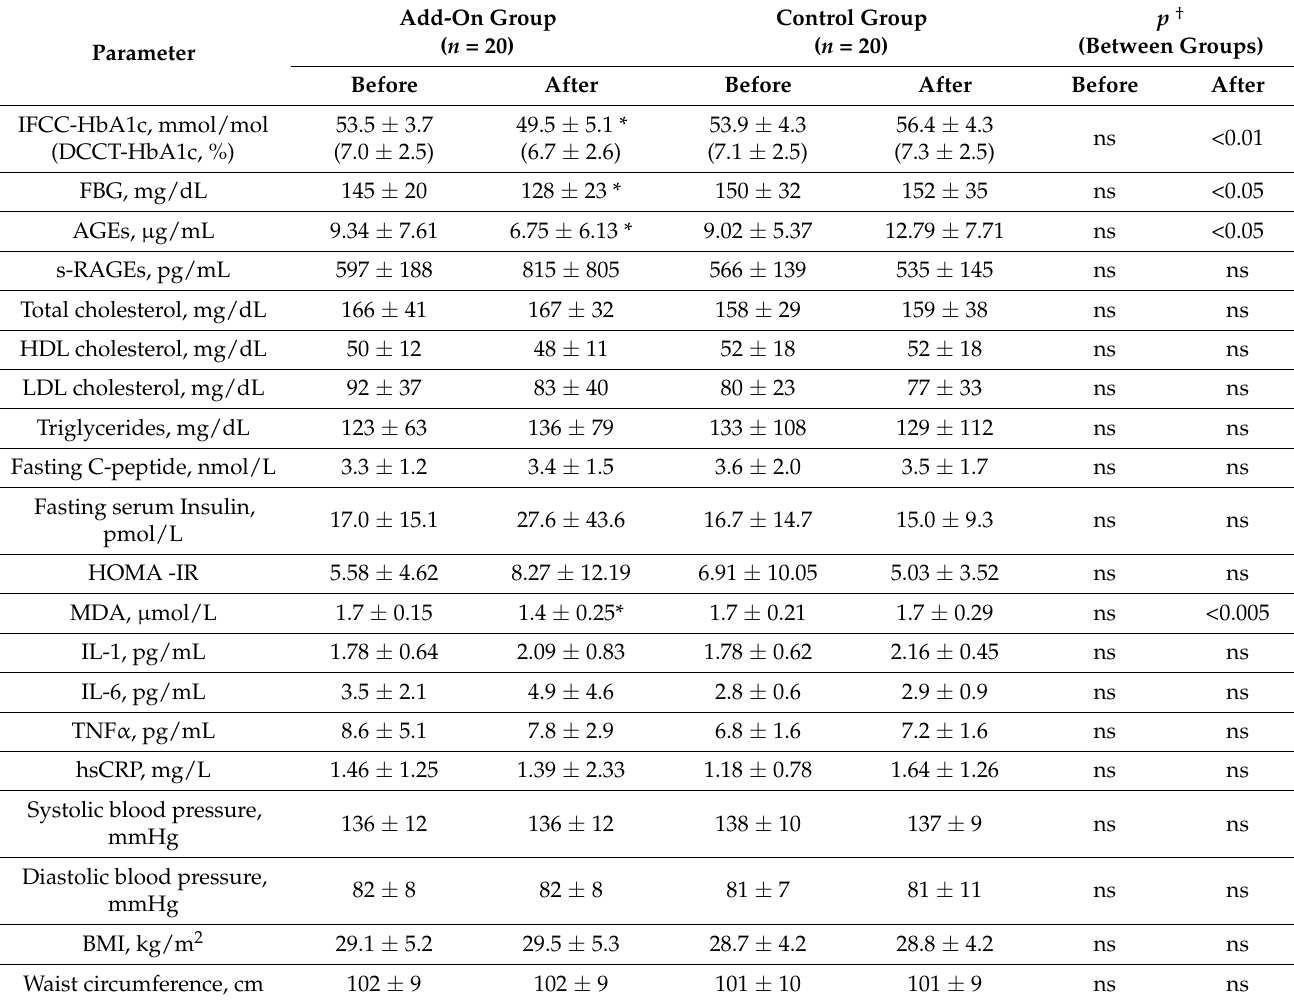
Table 2. Hematochemical parameters of patients at the baseline and after 12 weeks of treatment. For continuous data, values are mean ±